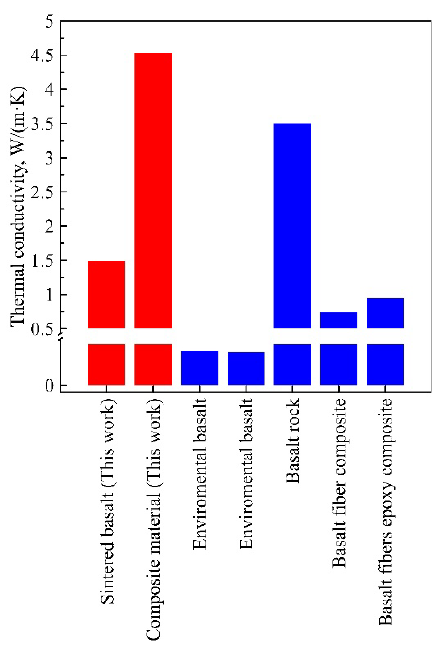
Figure 6. Thermal conductivity of experimental and literature data